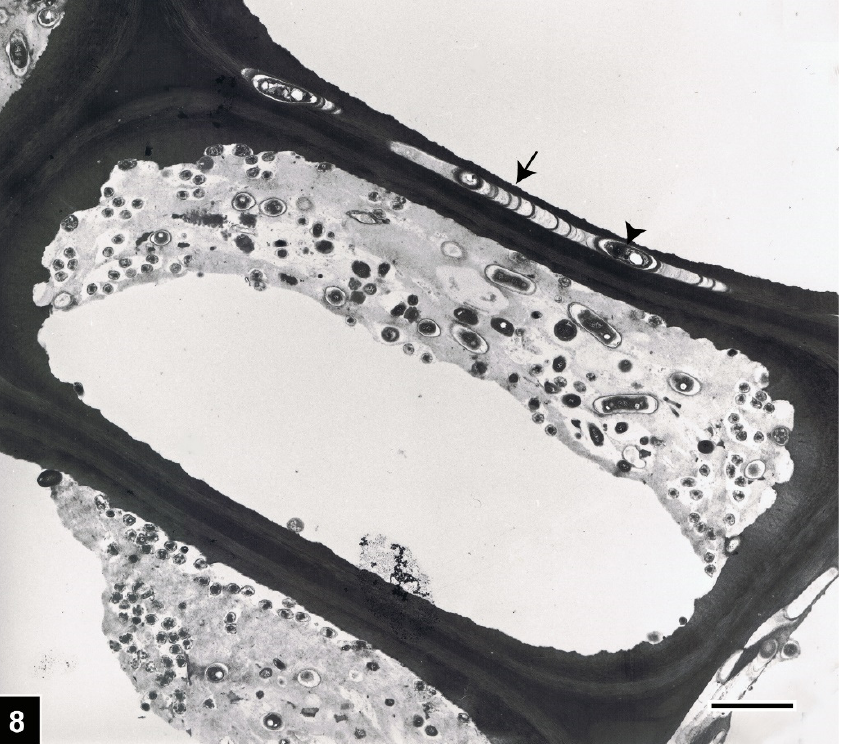
Figure 8. TEM of a transverse section through a Pinus radiata tracheid attacked by tunnelling bacteria (arrowhead). Tunnelling (arrow) within the S1 layer appears to be along the microfibrils. Scale bar = 8 µm. The image is reproduced from Singh et al. (2019) IAWA J.